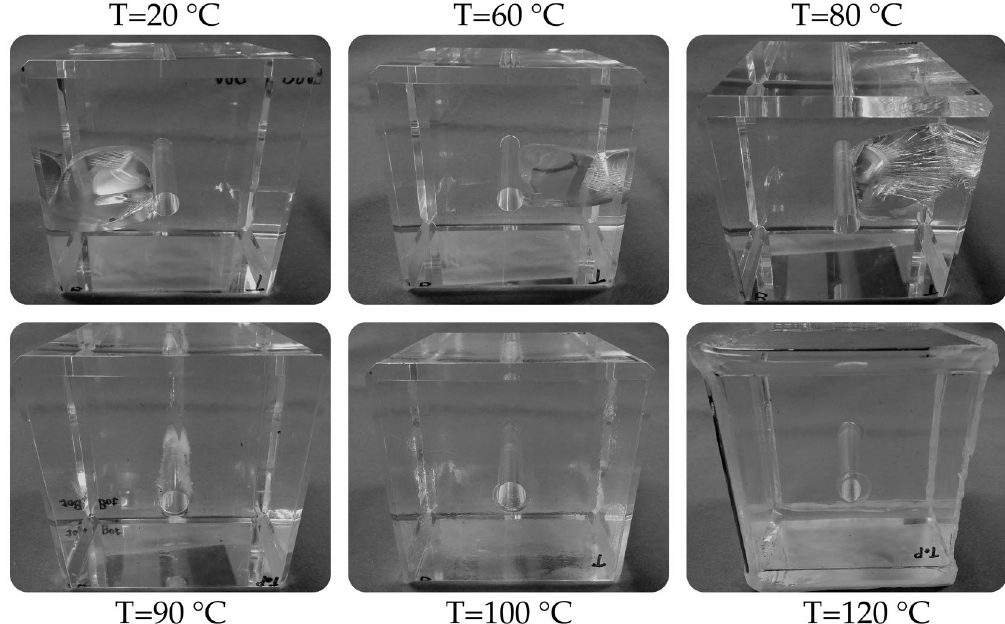
90 ◦ C, while no fracture occurred at ≤